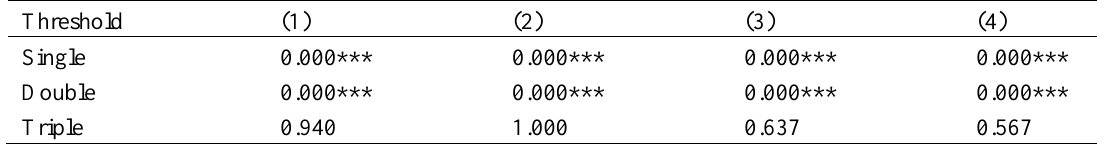
Table 3 : Tests for threshold effect : P-values from LM tests